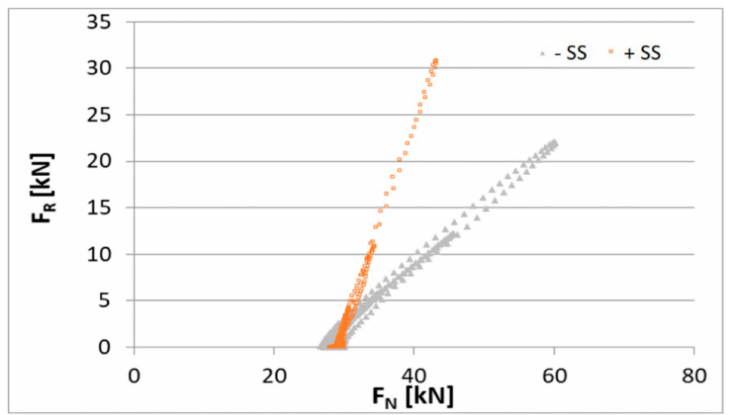
Figure 11. Influence of the support system on the correlation between the impact force F R and the tensile force F N .